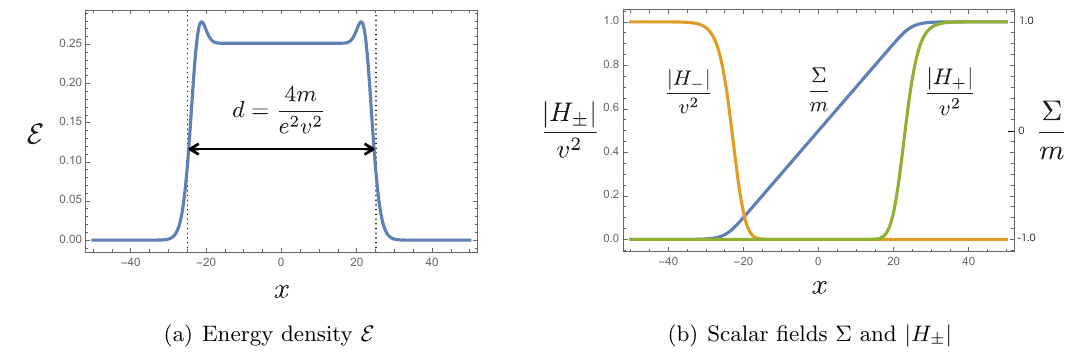
Figure 1 . The pro(cid:12)le of domain wall for d = 50, m = (cid:25) , v 2 = 2: (a) the energy density = @ E